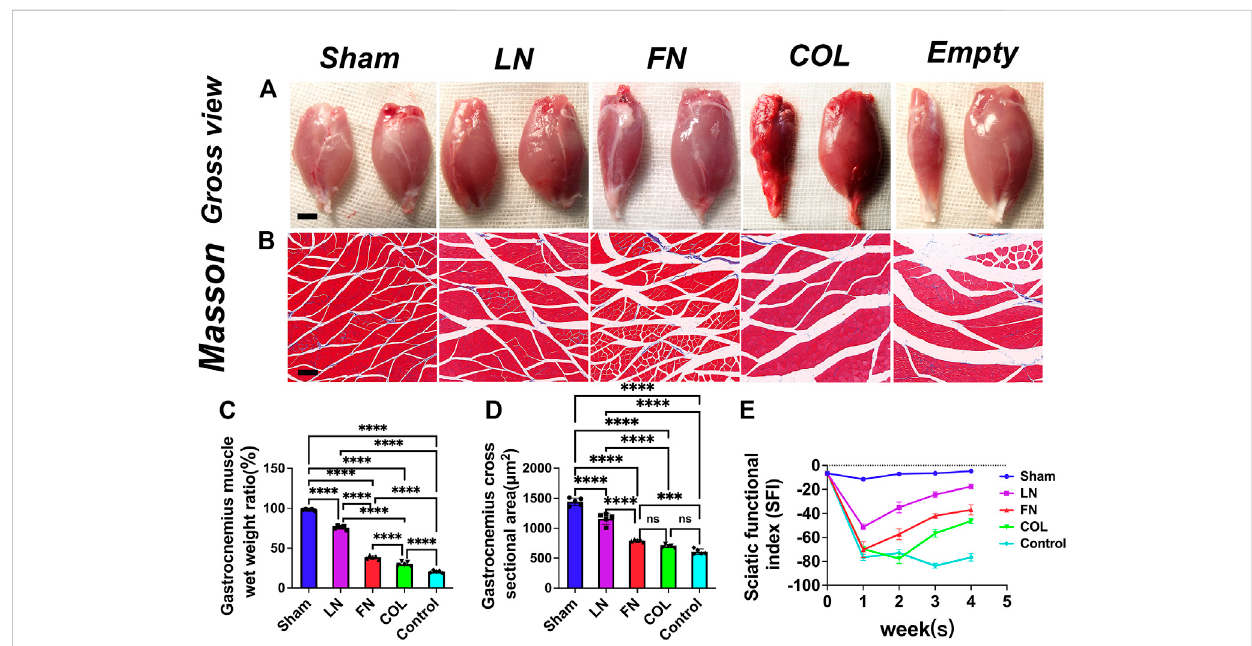
FIGURE 8 Atrophy of innervated muscles at 4 weeks after model construction. Representative gross view of gastrocnemius muscle in each group (A) : the injuredsideisontheleft,andthenormalsideisontheright.Massonstainingofthegastrocnemiusmuscleontheinjuredsideofthenerve (B) .Wetweight ratio of gastrocnemius muscle (injured side/normal side) [ (C) , n = 5]. Average cross-sectional area of muscle fi bers in each group [ (D) , n = 5]. Sciatic functionalindex(SFI)wasmeasuredineachgroupaftersurgery[ (E) , n =3].Scalebar (A) =5 mm.Scalebar (B) =50 μ m*** p < 0.001,**** p < 0.0001, ns p > 0.05. One-way ANOVA with Tukey ’ s post-hoc